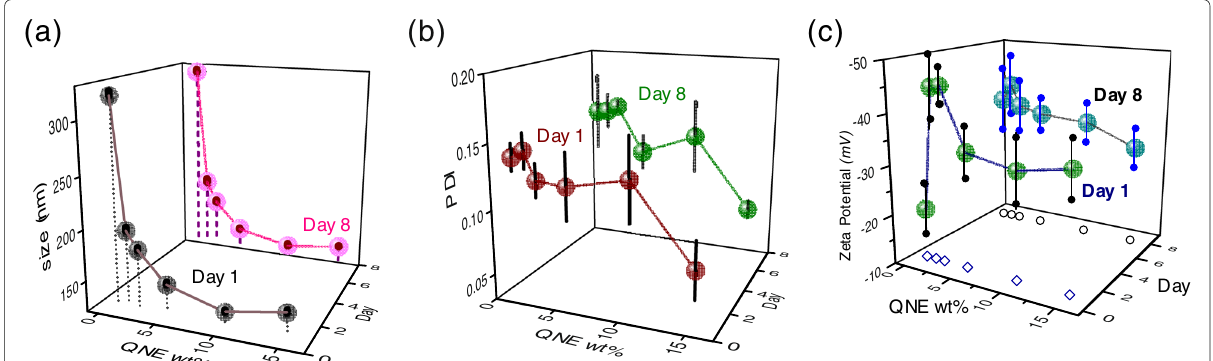
Fig. 2 Variation of a d z , b PDI, and c ζ potential of a 10 wt% soybean oil nanoemulsion, immediately upon fabrication, and after a week, as a function of the wt% of QNaturale (cid:2) (QNE) in the